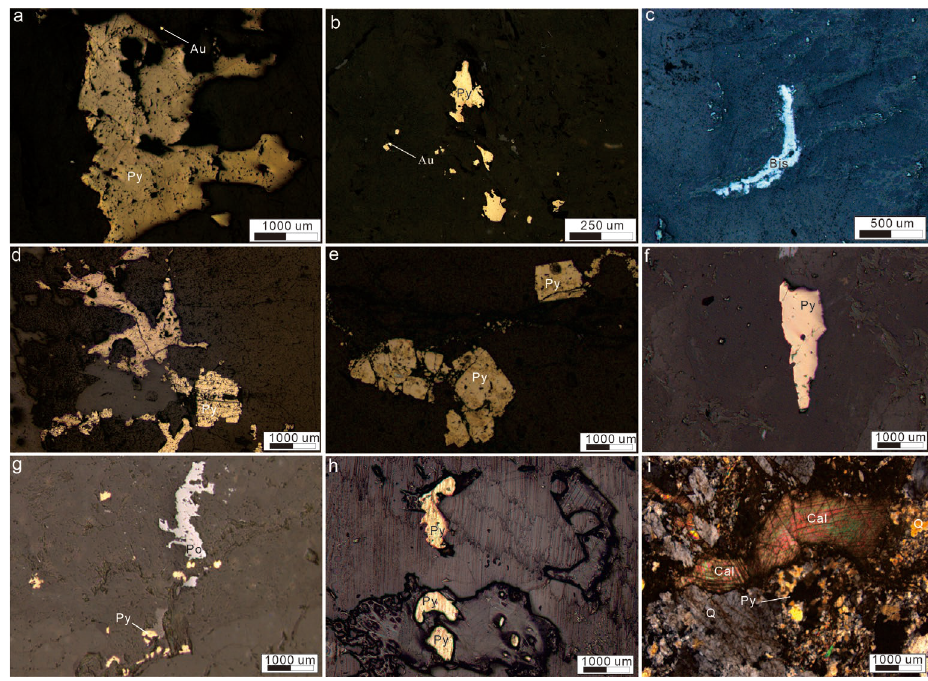
Figure 4. Photomicrographs showing the textural characteristics of pyrite and its relationships with native gold and other sulfides. ( a ). The textural characteristics of native gold and Py2; ( b ). The textural characteristics of native gold and Py2; ( c ). The textural characteristics of bismuthinite; ( d ). The textural characteristics of Py1; ( e ). The textural characteristics of Py1; ( f ). The textural characteristics of Py2; ( g ). The textural characteristics of Py2 and pyrrhotine; ( h ). The textural characteristics of Py3;